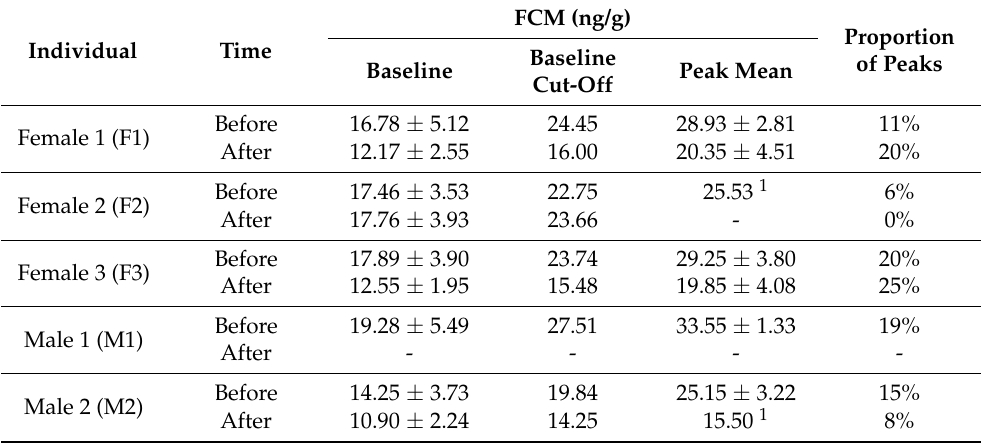
Table 2. Individual baseline ( ± SD) fecal cortisol metabolite (FCM) concentrations, baseline cut-off (calculated as baseline levels + 1.5 ∗ SD), peak mean ( ± SD) FCM concentrations, and proportion of peaks before and after the death of the dominant male of the lion